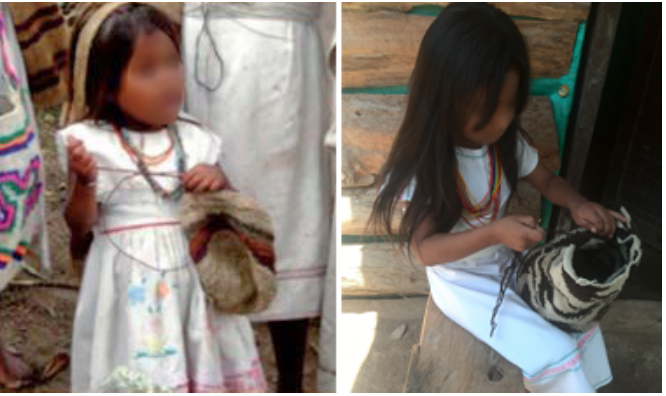
Figure 3. Two Arhuaco Girls Knitting. Photos by Dwrya Izquierdo